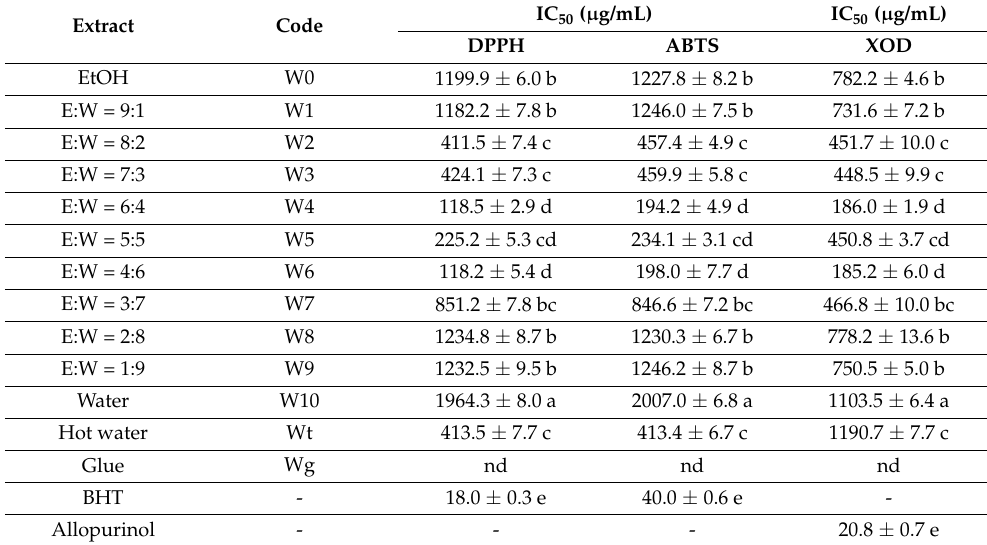
Values represent means ± SD (standard deviation). Alphabetic letters indicate statistical symbols generated by one-way ANOVA using Duncan’s test ( α = 5%). Values with similar letters in each column are not significantly different ( p < 0.05) ( n = 3). BHT: Butylated hydroxytoluene; nd: not detectable; ‘-’: not